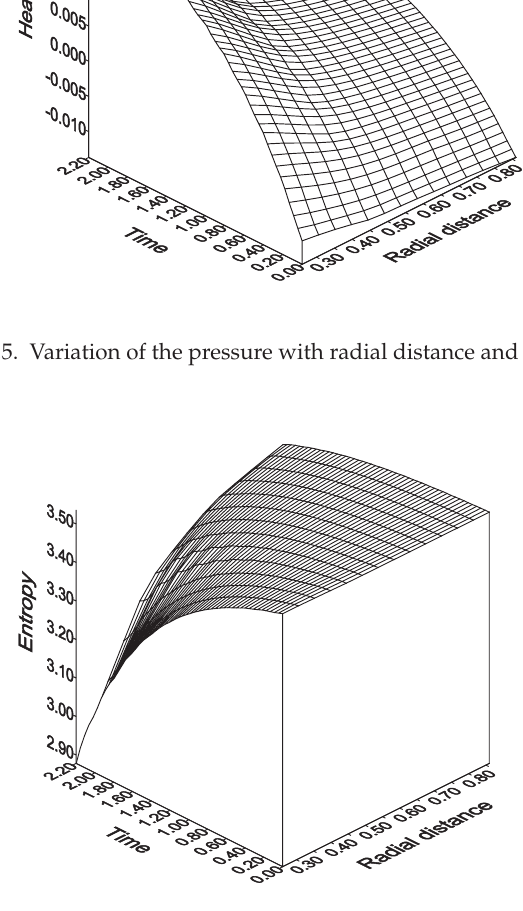
Figure 4.6 . Variation of the entropy with radial distance and